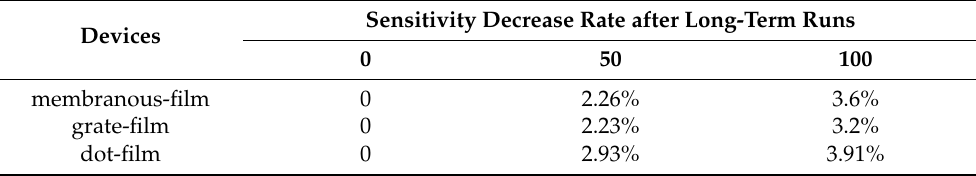
Table 3. The sensitivity decrease rate after long-term runs.